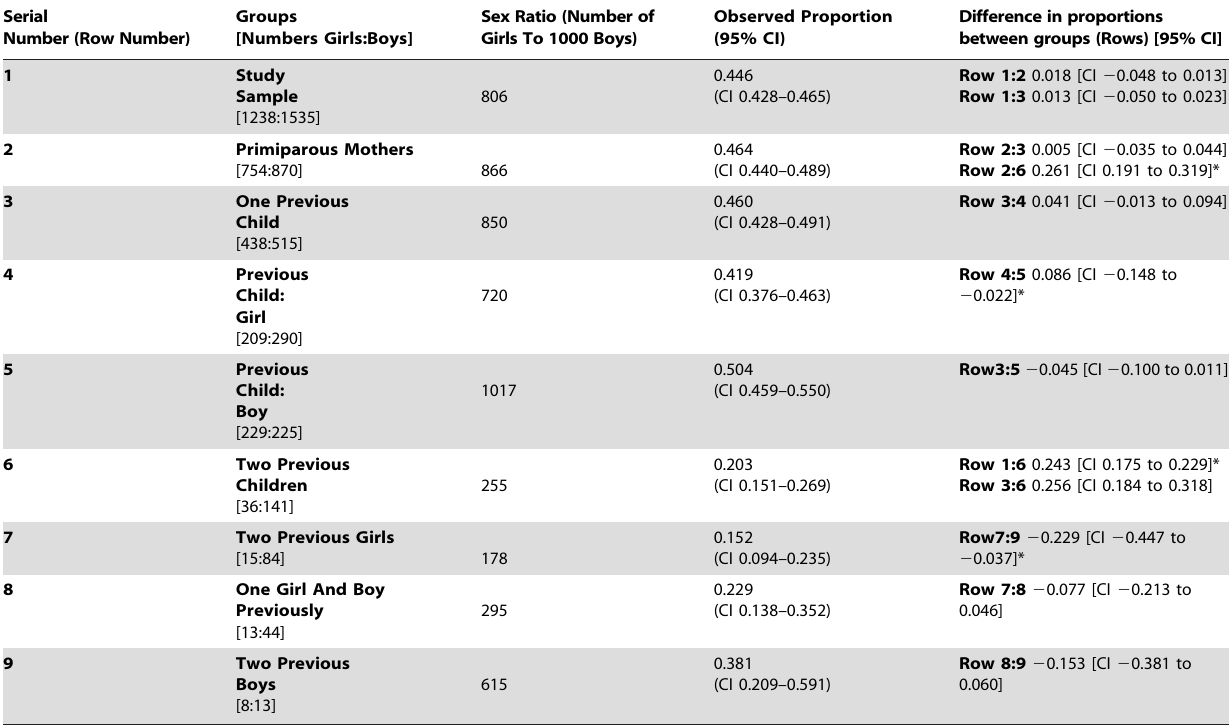
Table 1. Sex Ratio in different Groups.